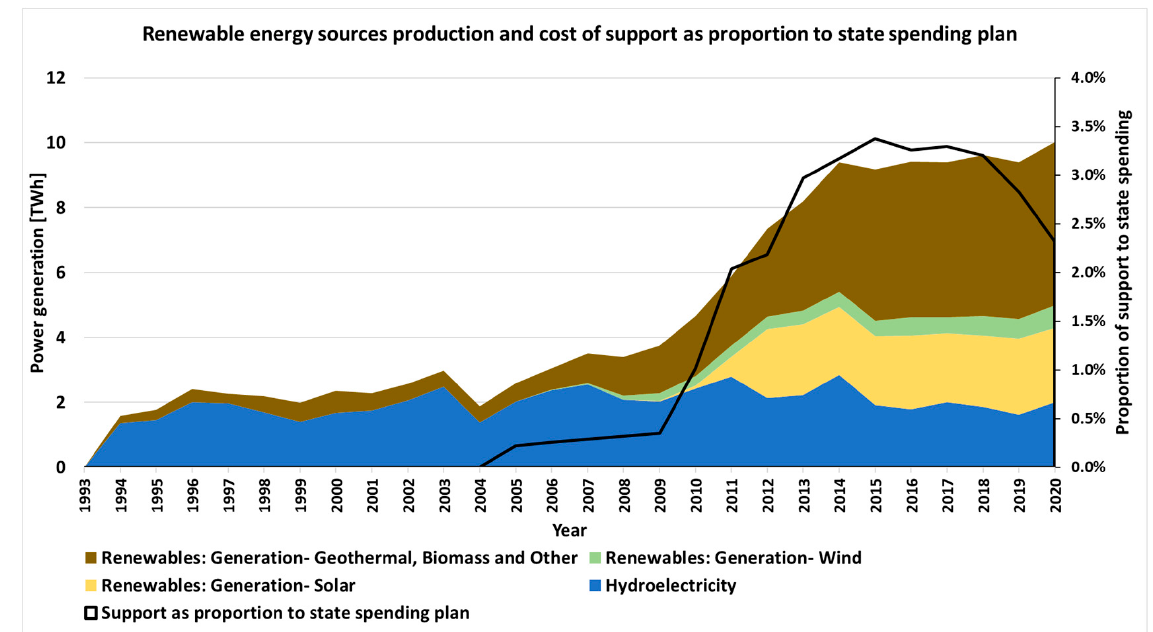
Figure 4. Renewable energy production and costs in Czech Republic.